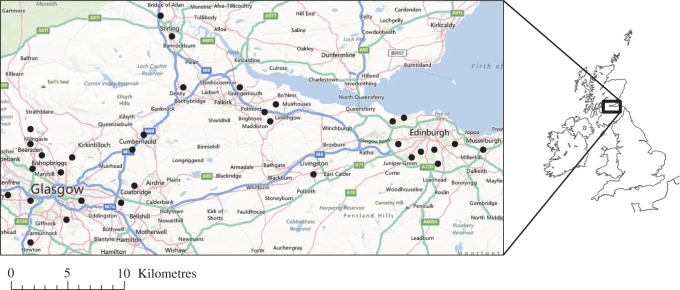
Map of central Scotland showing approximate locations of woodland sites (black dots) surveyed in 2011.